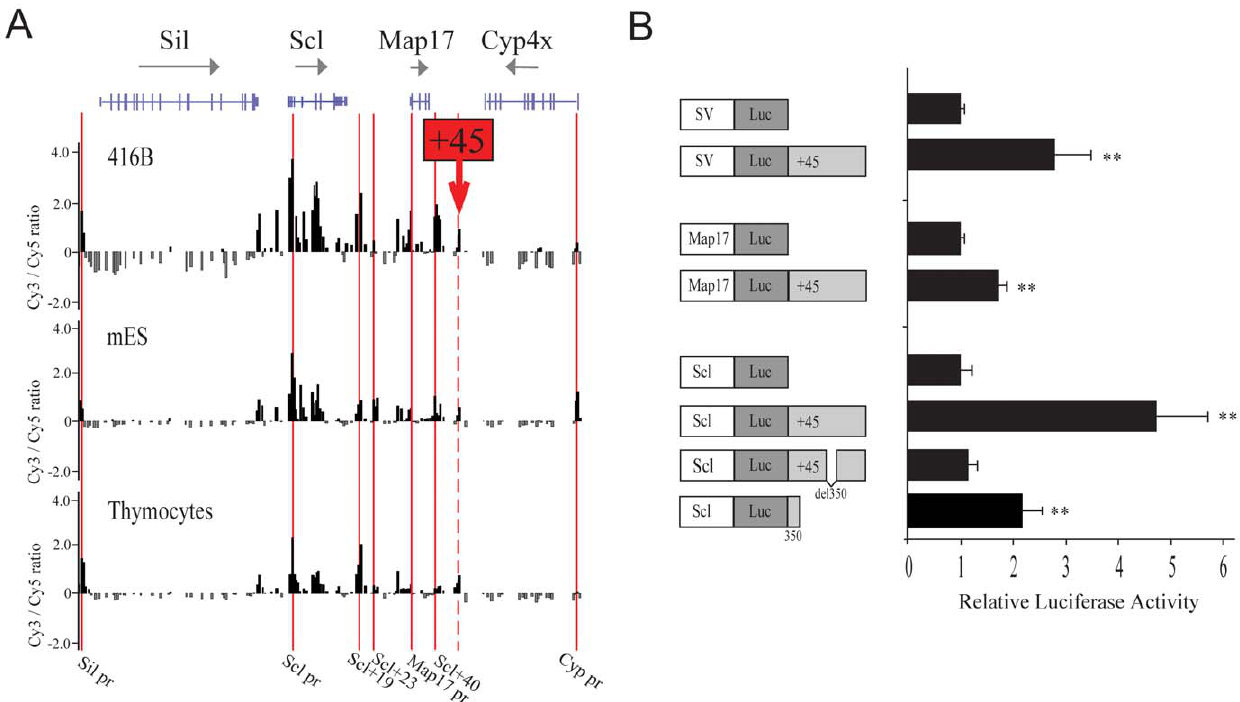
Figure 1. Identification and functional analysis of a novel 1.76 kb Scl element located 45 kb downstream from Scl promoter. ( A ) DNaseI hypersensitive profiles across 130 kb (NCBI37/mm9 chr4:114,670,057–114,799,426) of the extended Scl locus in 3 cell types: mouse haematopoietic progenitors (416B), mouse embryonic stem cells (mES) and primary mouse thymocytes. The location of the 4 genes at the locus are represented at the top of the figure (Sil, Scl, Map17 and Cyp4x) with direction of transcription indicated by the arrows and translated and untranslated exons represented by wide and narrow bars respectively. The location of known key regulatory elements is indicated by the red bars (Sil promoter, Scl promoter, Scl + 19, Scl + 23, Map17 promoter, Scl + 40, and Cyp promoter), and the location of the putative + 45 element is indicated with a dashed red line. The data presented is a representative experiment showing fold enrichment over non-enriched input plotted (log 2 ) against genomic position. ( B ) Luciferase activity is increased in 416B cells stably transfected with constructs containing the + 45 element (SV/Luc/ + 45, Map17/Luc/ + 45 and Scl/Luc/ + 45) when compared to promoter alone. The 350 bp core region of the + 45 element (Scl/Luc/ + 45del350) is necessary but not sufficient for full transcriptional enhancement from the Scl/Luc/ + 45 construct. The left panel represents the constructs diagrammatically. Luciferase activity was calculated as fold increase over the promoter only construct. The data representing mean + / 2 SD relative luciferase activity from 5 independent experiments, each performed in triplicate. ** indicated p , 0.01 compared to promoter alone.